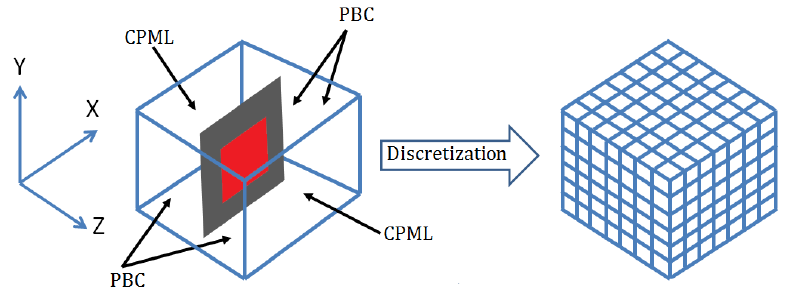
Figure 1. Unit cell for finite-difference time-domain (FDTD) simulation for a planar array. Convolutional perfectly matched layer (CPML) and Periodic Boundary Condition (PBC) are the boundaries of the problem space. This unit cell has one patch antenna of an infinite planar array. The red color area is the metal patch and gray color area is the substrate